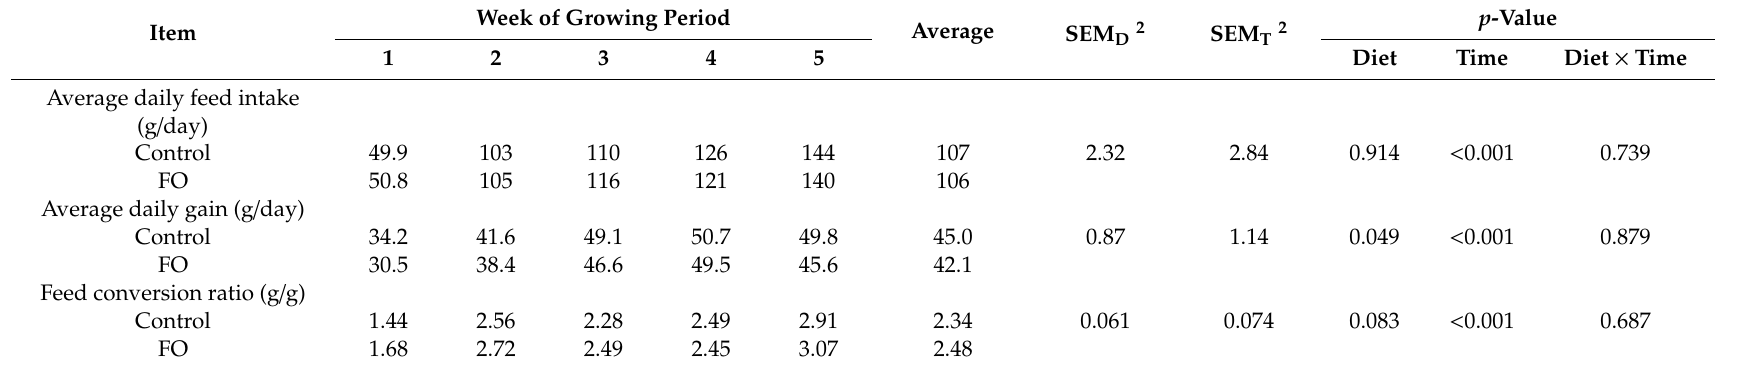
Table 2. Feed intake, daily gain, and feed conversion ratio of fattening rabbits fed diets with either lard (control) or fish oil (FO) as the fat source from 25 to 60 days of age 1